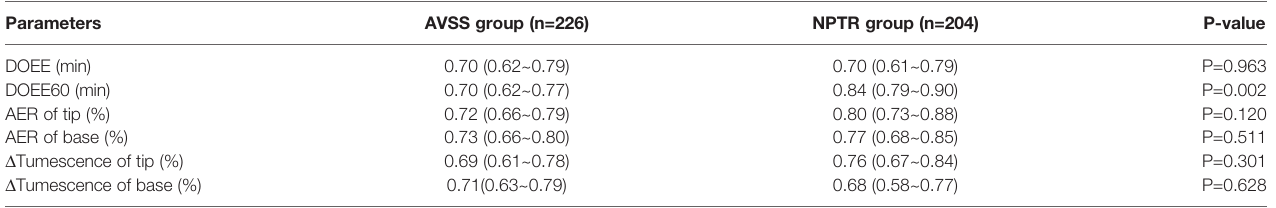
TABLE 2 | Comparison between AVSS group and NPTR group via AUC in tadala fi l responders prediction. Parameters